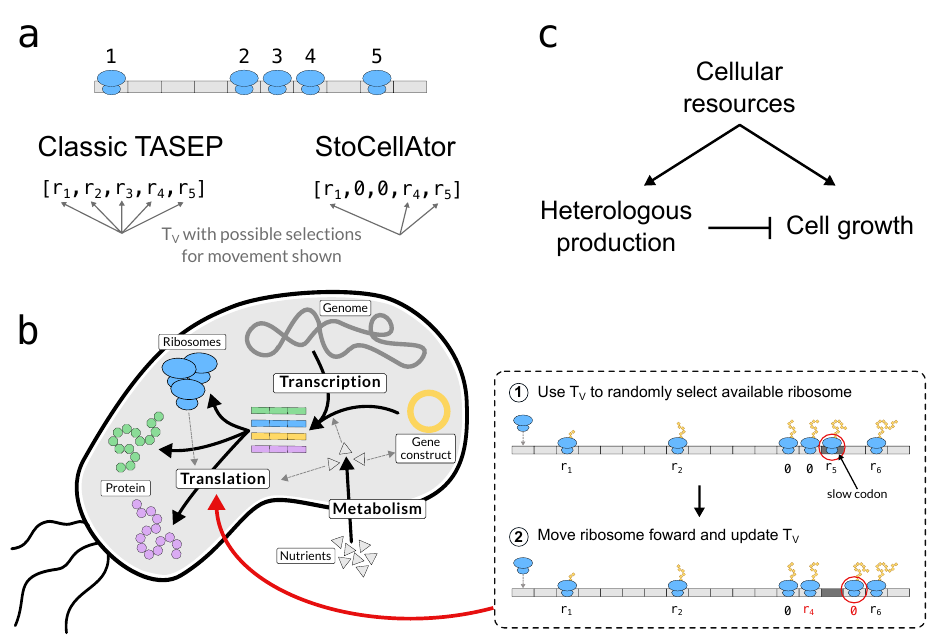
Figure 2. StoCellAtor’s translation model in context. ( a ) The difference between classic TASEP and StoCellAtor in terms of choosing ribosome movement via the transition vector (T V ). ( b ) The simulation steps taken during translation in the context of a resource-limited whole-cell model, which considers nutrient metabolism, transcription and translation. Step 1: a non-queuing ribosome is selected for movement. Step 2: the chosen ribosome position is updated. This ribosome might become “queuing”, while the ribosome behind it becomes free to move. This is reflected in the updated T V (red values). ( c ) A top-level summary of the whole-cell model, showing the links among the cell’s resources, its heterologous protein production and its growth. The activation and inhibition arrows denote general effects and not specific reactions.